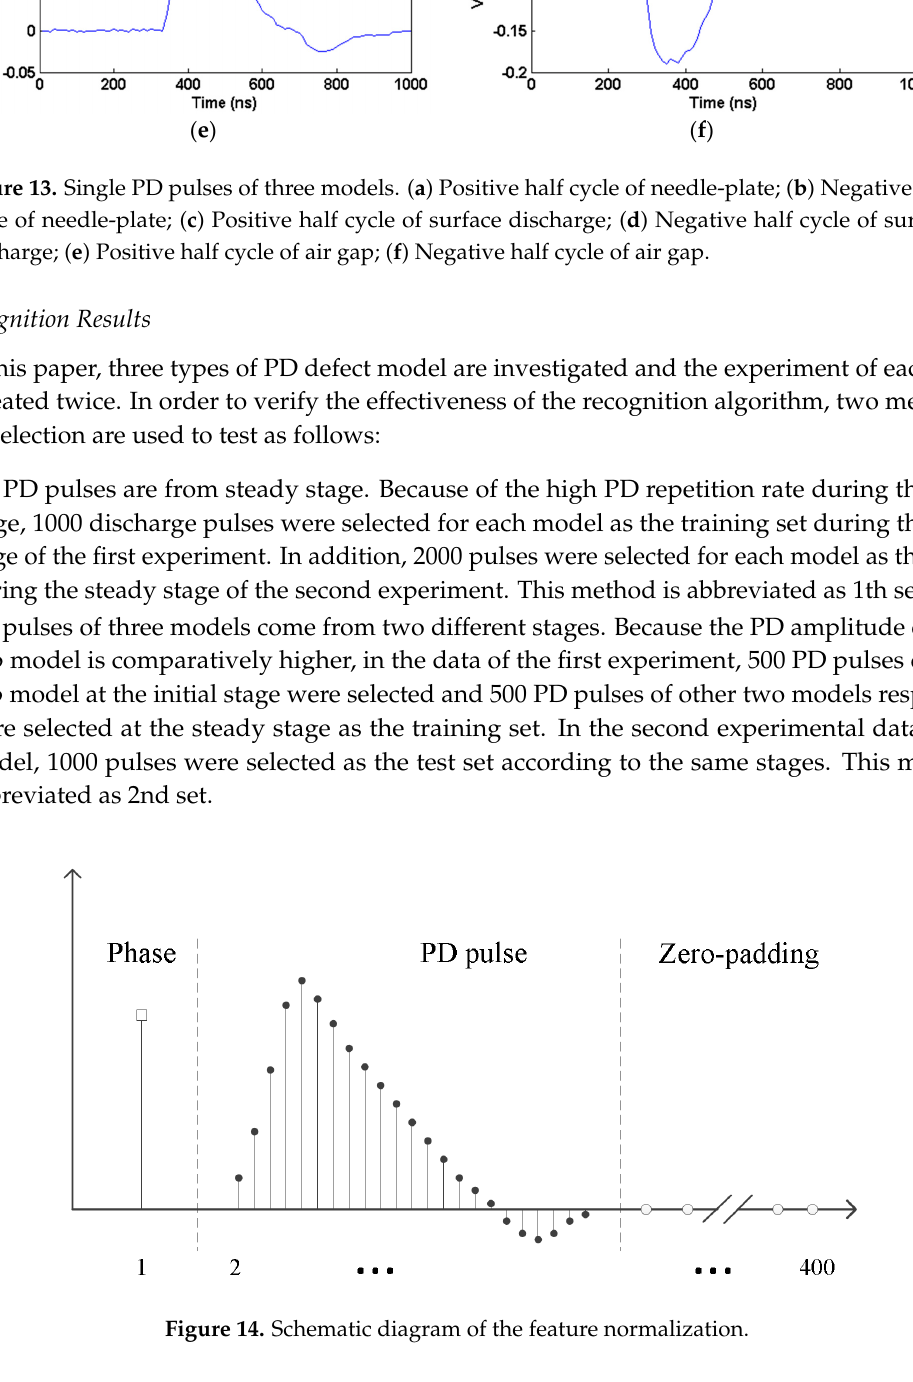
Figure 14. Schematic diagram of the feature normalization.